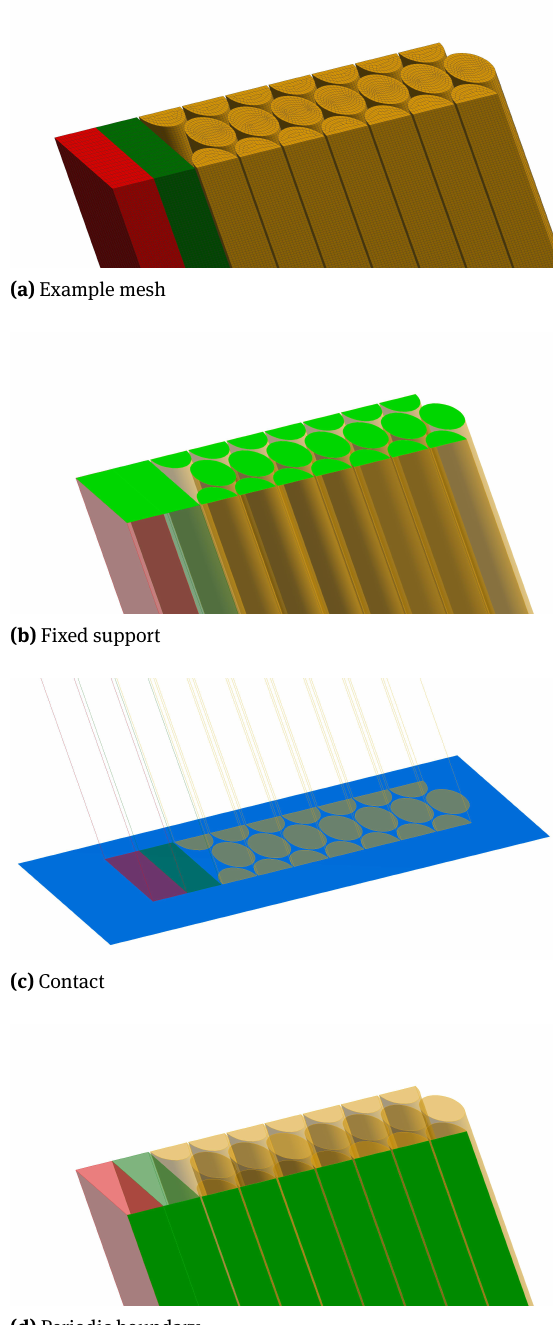
Figure 5: Boundary